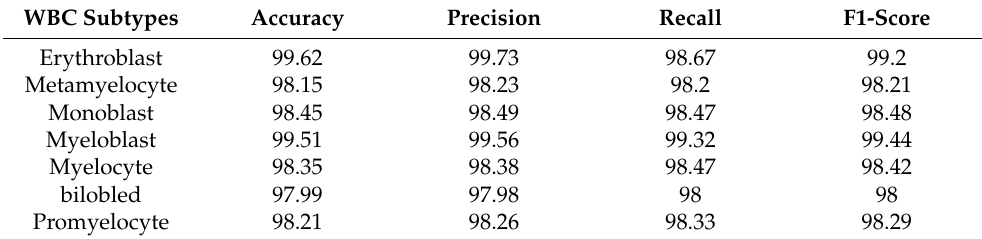
Table 5. Multi-class classification on single-cell morphology dataset.